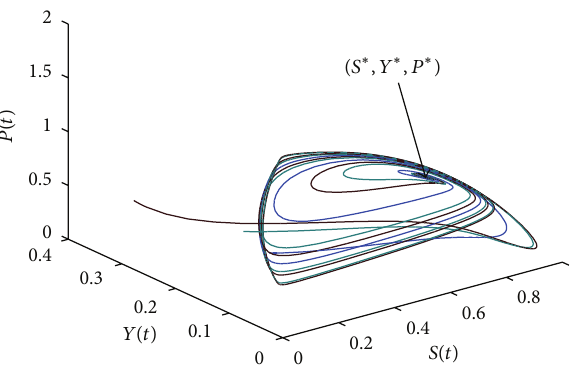
Figure 3: Phase portrait ( 𝑆 - 𝑌 - 𝑃 space) of model system (20) with = 1.0653 and 𝑢 = 0.483 and differential initial values, 𝜎 𝛿 1𝛿 which indicates model system (20) is globally stable around 𝑀 ∗ (0.5648, 0,0.9406, 0.0501) .